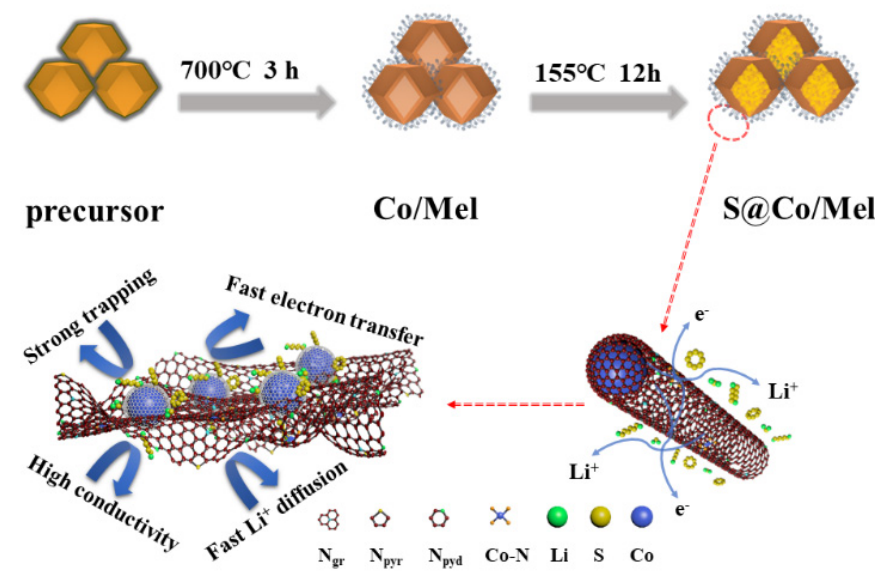
Figure 1. Schematic illustration of the synthesis and structure of S@Co/Mel composite.